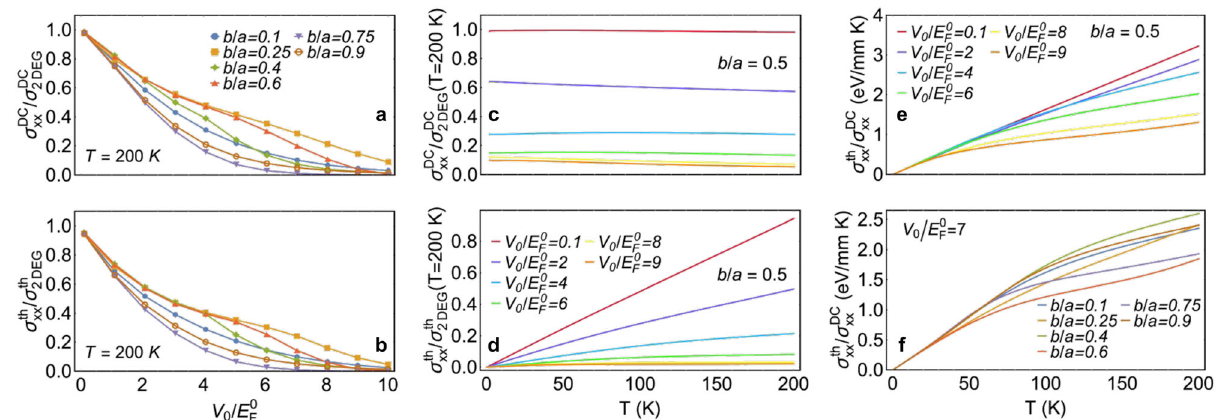
Fig. 3 | Q-phase modulation of the DC electrical and thermal conductivities. Component of the 2D electrical ( a ) and thermal ( b ) conductivity tensors along the periodicity direction as a function of the normalized image potential strength V 0 = E 0 F for several values of the b / a ratio (see legend), calculated at T =200K and divided by the respective conductivities of a 2DEG at the same temperature. Temperature dependence of the electrical ( c ) and thermal ( d )